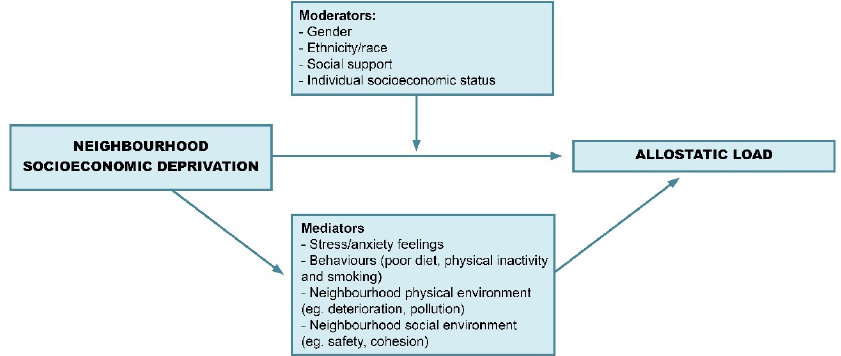
Figure 4. Conceptual framework for the associations between neighborhood socioeconomic deprivation and allostatic load.